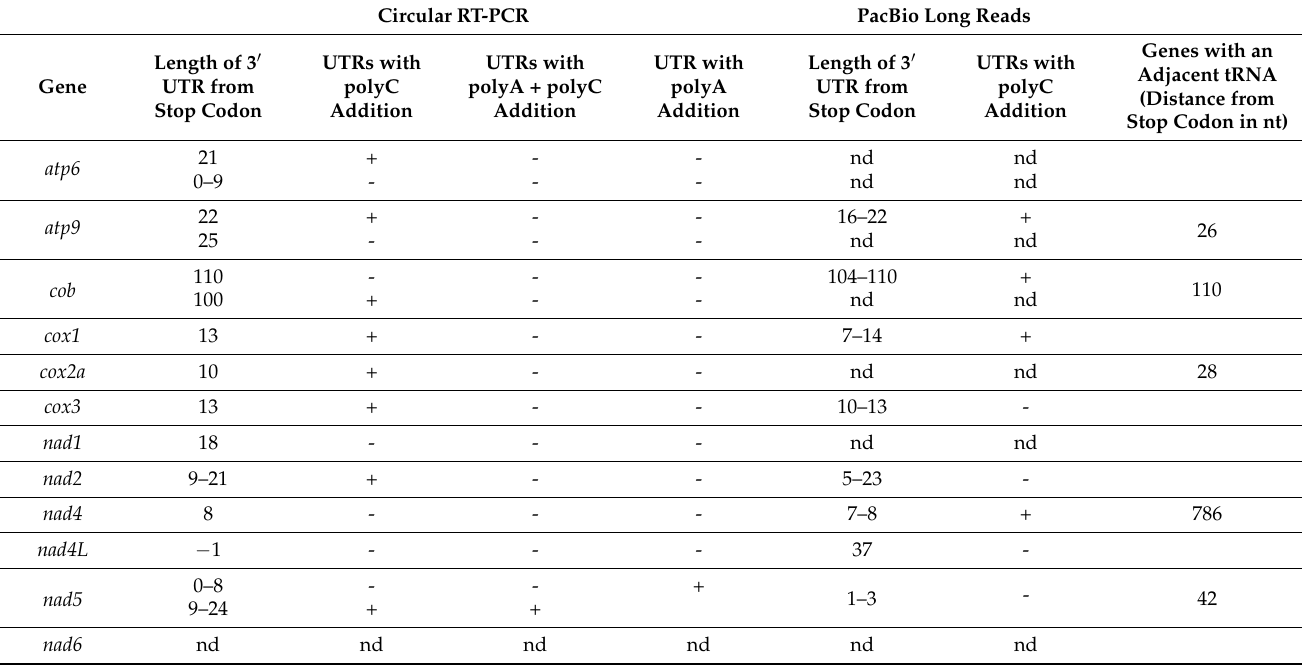
Table 2. Lengths of the most abundant 3 (cid:48) UTRs found in Pediastrum duplex and those found with a non-template addition Circular